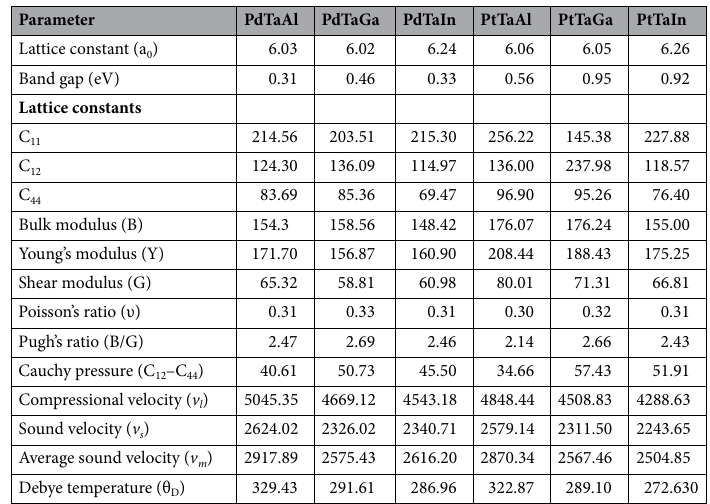
Table 1. Lattice constants (in Å), energy gaps (in eV) elastic constants and mechanical parameters (in GPa), Debye temperature (in K), compressional velocity (in m/s), sound velocity (in m/s) and average sound velocity (in m/s) as calculated for XTaZ alloys.